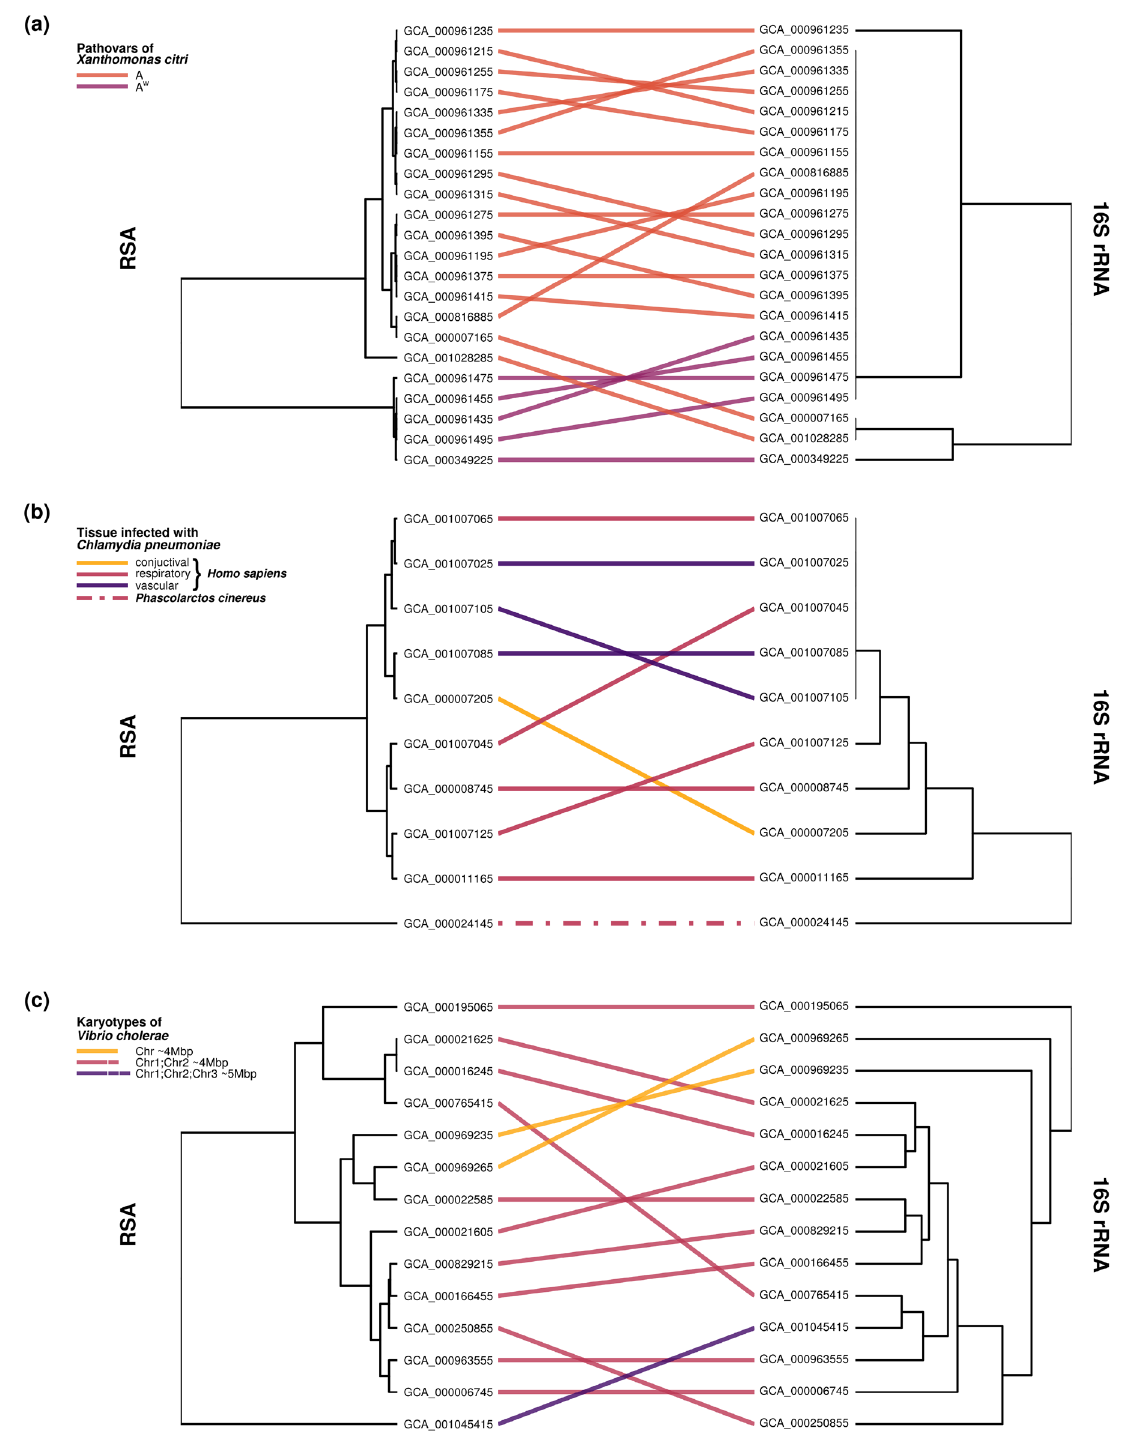
Figure 4. (Previous page.) Hierarchical clustering of bacteria at the intraspecies level, comparing solutions obtained by RSA and 16S rRNA method. Each subplot shows a tanglegram with RSA-based dendrogram on the left and 16S rRNA-based dendrogram on the right. Lines connect the same bacteria from two dendrograms. The color/type of the line represents the feature of the bacterium it connects. ( a ) 22 strains of Xanthomonas citri belong to two different pathovars: A ( orange ) and A W ( purple ). ( b ) 10 strains of Chlamydia pneumoniae are isolated from different tissues: conjuctival ( yellow ), respiratory ( magenta ) and vascular ( violet ). 9 strains represented with solid line are human ( Homo sapiens ) pathogens while the one strain represented by dashed line is koala ( Phascolarctos cinereus ) pathogen. ( c ) 14 strains of Vibrio cholerae are colored based on their karyotype. 3 Mb) and Chr2 ( 1 Mb) ( magenta ). 2 strains have one 11 strains have two circular chromosomes Chr1 ( 4 ∼ ∼ ∼ Mb long circular chromosome ( yellow ). One strain has three chromosomes Chr1 ( 3 Mb), Chr2 ( 1 Mb) and ∼ ∼ Chr3 ( 1 Mb) ( violet ∼